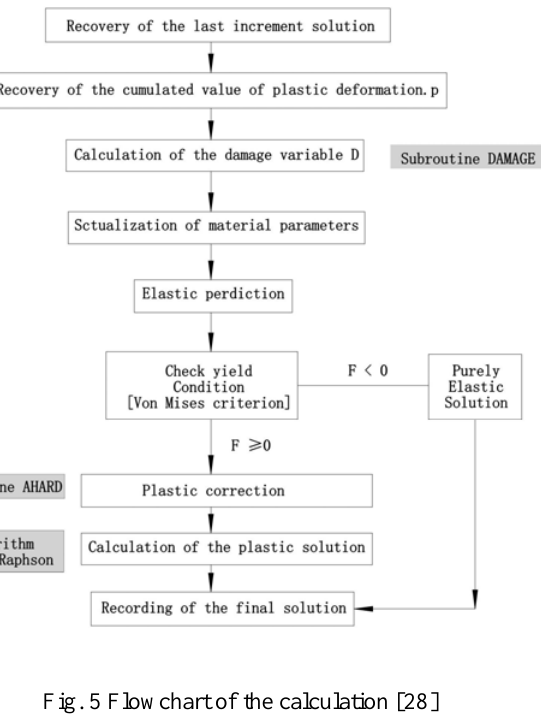
Fig. 5 Flowchart of the calculation